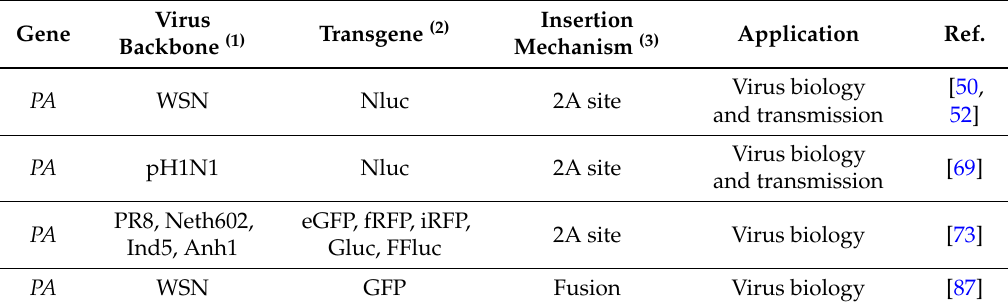
Figure 4. PA reporter influenza A viruses: Schematic representation of the PA segment from WT ( A ) and reporter ( B – D ) influenza A viruses as described in Figure 1. Influenza A WT PA gene segment encodes for both PA and PA-X, which shares the N-terminal amino acids with PA but the C-terminus is in the +1 ORF via ribosomal frame shift. Nucleotide lengths for the NCR, ψ , and PA segment are indicated; ( B , C ) Bicistronic transcription of PA and reporter gene: Insertion of the 2A autocleavage site separates PA from reporter gene. Packaging signals encoding the 3’ terminus of PA were WT ( B ) or mutated ( C ) to minimize interference with native ψ , which are duplicated at the 3’ NCR-proximal region; ( D ) PA fusion protein: Reporter genes were fused to native PA ORF. Packaging signals were duplicated after the protein stop transcription signal, before the 3’ NCR terminus. Table 4. Reporter-expressing recombinant influenza viruses in the viral